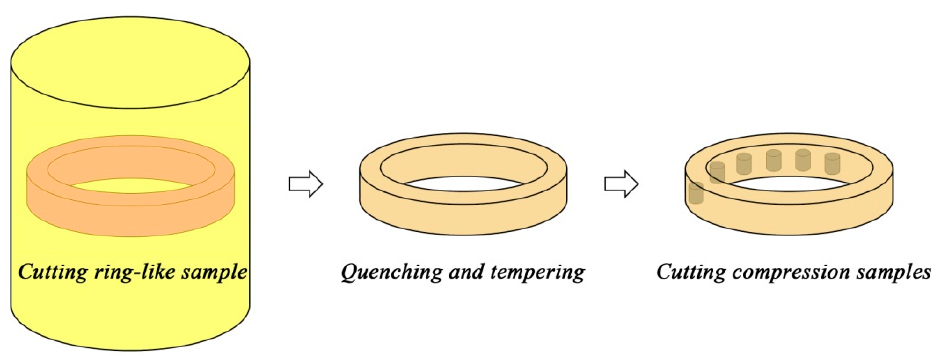
Figure 1. Schematic shows the preparation process of the samples for compression.